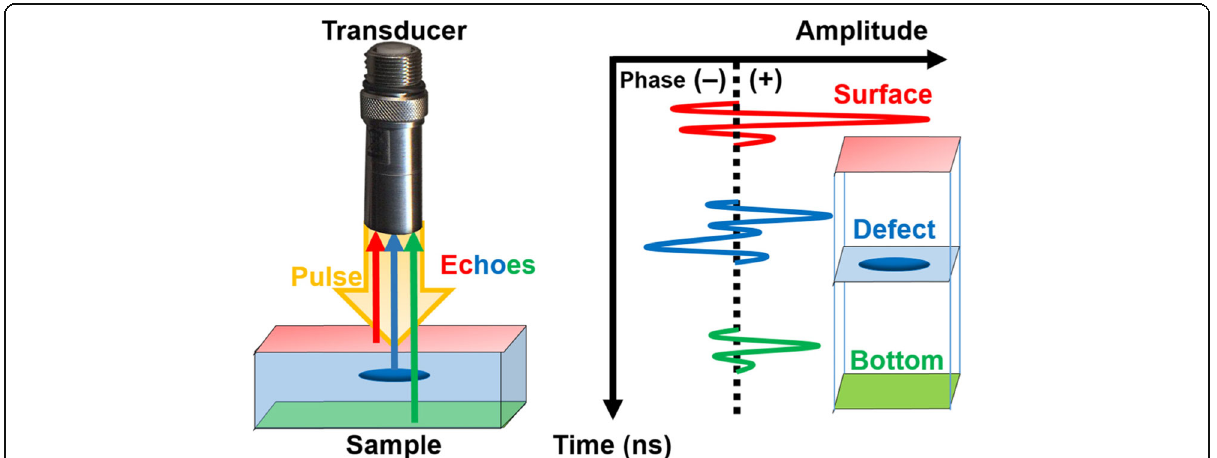
Fig. 1 Schematic showing the incident and reflected ultrasonic pulse (left) and histogram (right) showing the amplitude of the reflected echo (A- scan) after an ultrasonic pulse interacts with a